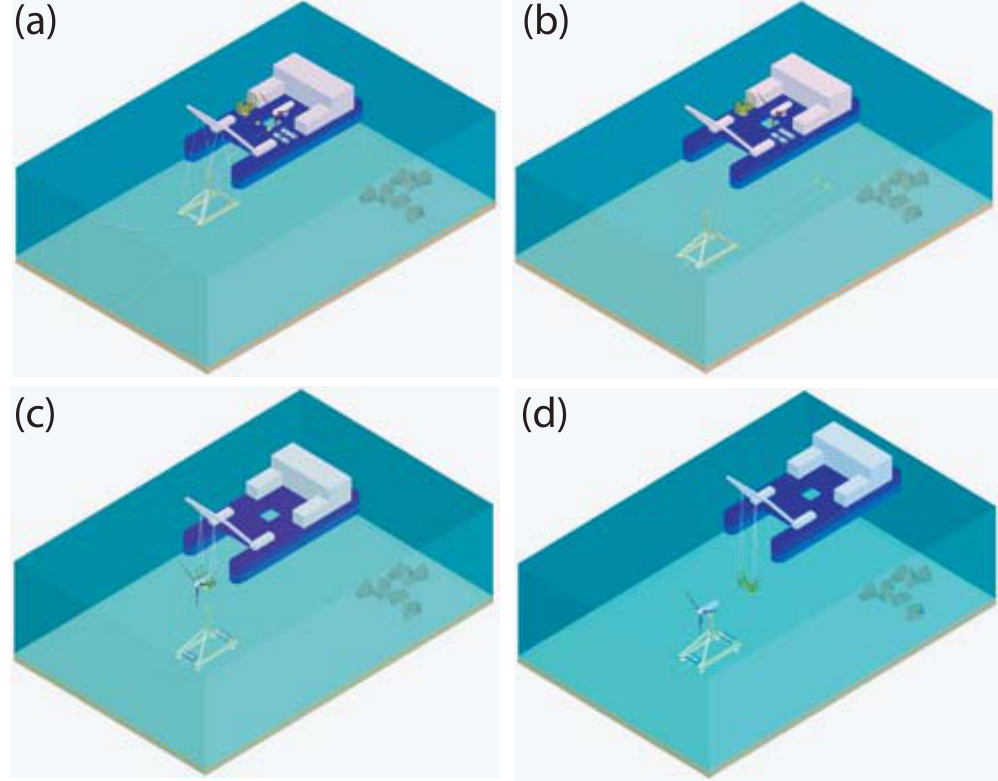
Figure 8. Installation procedure: ( a ) controlled descent of the base structure; ( b ) support structure on the seabed and deposited guide wires; ( c ) controlled descent of the nacelle; ( d ) removing the tool for nacelle installation and unstressing the guide